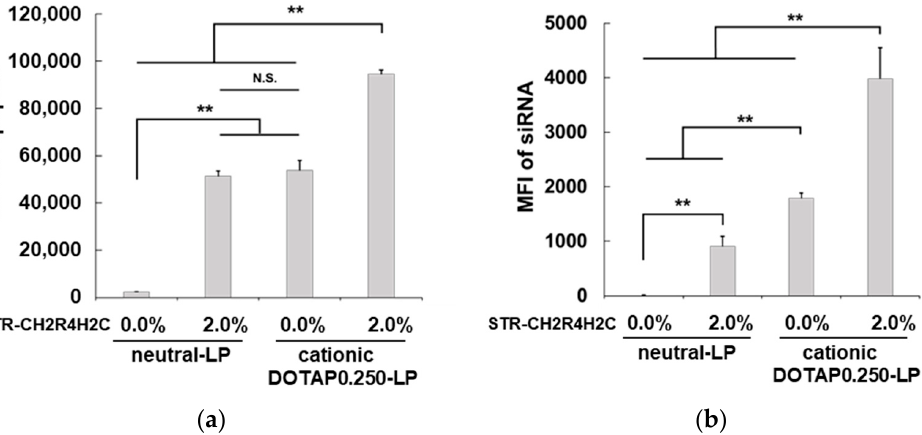
Figure 2. Cellular uptake of STR-CH2R4H2C-LP-siRNA lipoplexes and unmodified-LP-siRNA lipoplexes. Mean fluorescence intensities (MFI) per cell of ( a ) ATTO-labeled liposomes and ( b ) Cy5- siRNA in rat RPE cells. Neutral-LP-siRNA lipoplexes, DOTAP0.250-LP-siRNA lipoplexes, 2.0 mol% STR-CH2R4H2C-neutral-LP-siRNA lipoplexes, or 2.0 mol% STR-CH2R4H2C-DOTAP0.250-LP- siRNA lipoplexes were transfected into RPE cells (2.0 × 10 5 cells) in serum-free DMEM for 4 h (ATTO-DOPE, 0.2 µM; Cy5-siRNA, 0.158 µM). MFI per cell was measured by flow cytometry for 10,000 events. Each bar represents the mean ± SD ( n = 3). N.S. p > 0.05, ** p < 0.01.